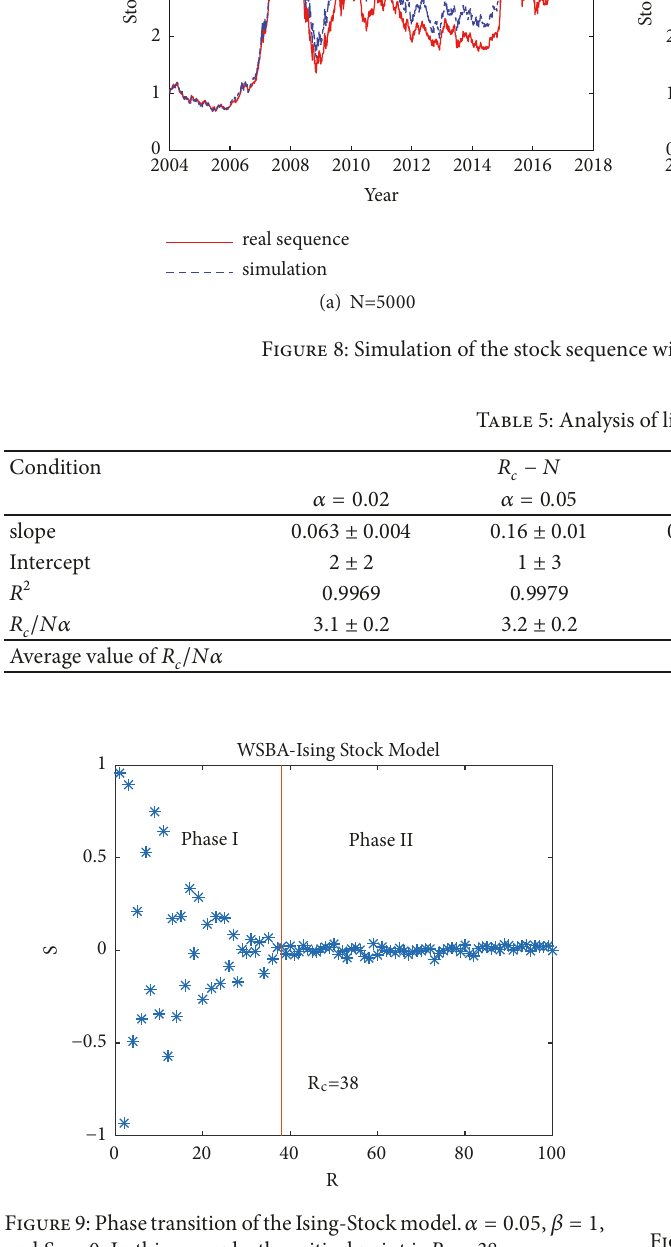
𝑁 and 𝛼 on 𝑅 𝑆 = 0 and 𝑐 . Here we set 𝑝 𝛽 = 100 . 𝑅 𝑁 and 𝛼 ,and 𝑅 /𝑁𝛼 isconstantly 𝑐 isproportionaltoboth 𝑐 3.1 ± 0.4